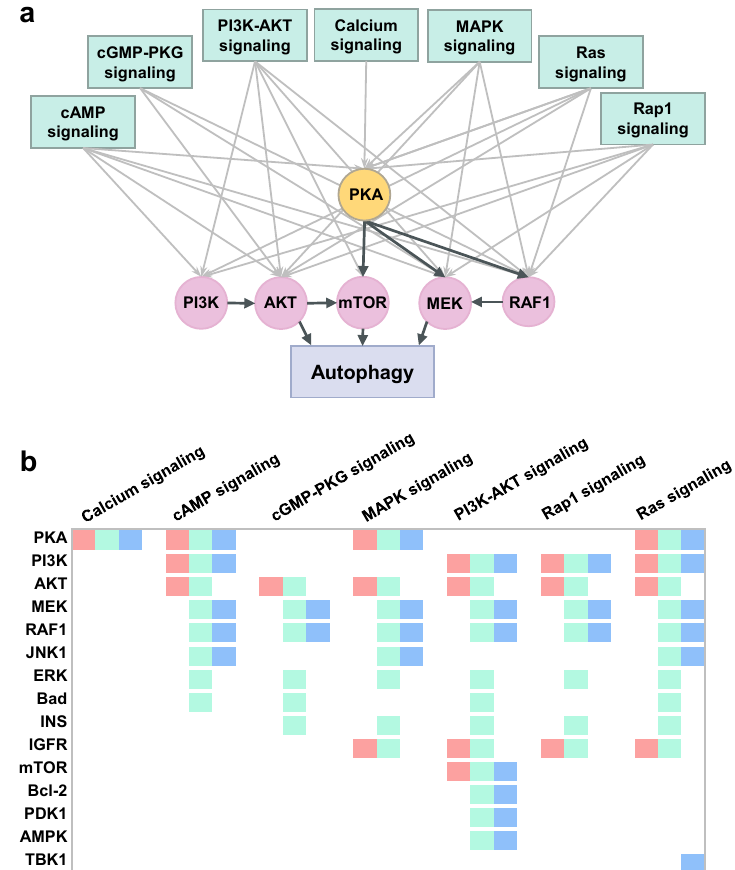
Figure 5. Signal transduction pathways most frequently affected by autophagy modulators and the most promiscuous targets belonging to these pathways. ( a ) Schematic diagram of the seven autophagy-related (ATG)-signal transduction pathways and highly promiscuous targets participating in those pathways (indicated by the gray arrow pointing from the pathway to the protein). The target proteins are shown in light violet circles, except for a pivotal target (PKA) (shown in yellow ). Bold face black arrows from X to Y means that X regulates Y. ( b ) Target-pathway mapping for the most prominent ATG-signal transduction pathways ( abscissas ) and ATG-signaling targets ( ordinate ). The color blocks associated with each protein indicate that it is targeted by autophagy activators ( green ), inhibitors ( red ), and dual-modulators ( blue ). Note that mTOR is also targeted by all three groups of